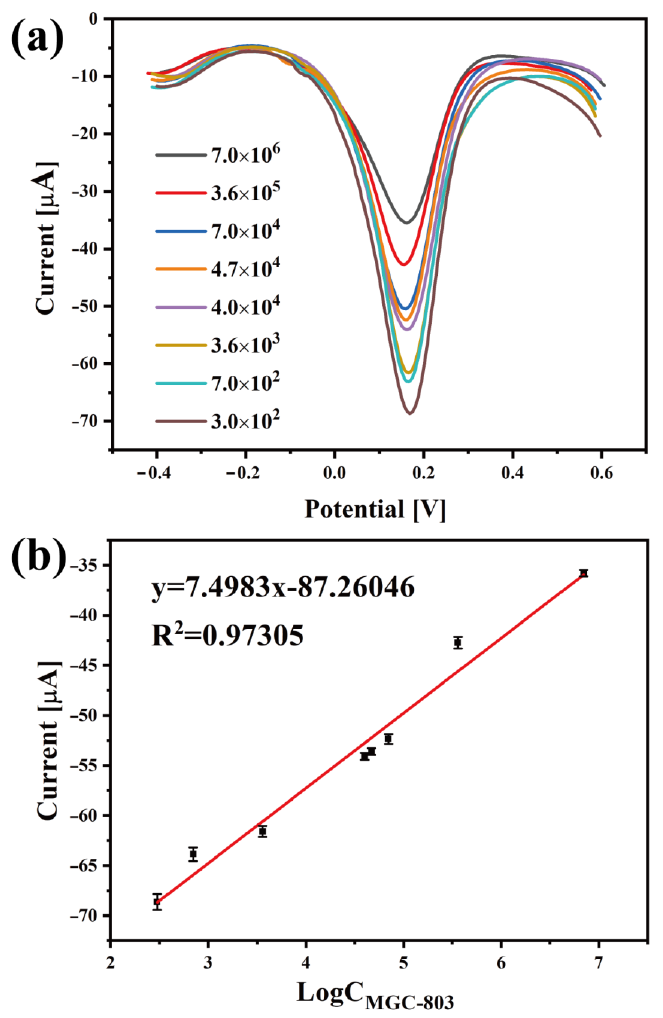
Figure 5. ( a ) The DPV currents of GO-AuNSs@rBSA-FA-labeled electrodes for detecting different concentrations of MGC-803 cells in the range from 3 × 10 2 –7 × 10 6 cell/mL. ( b ) The calibration curve of DpAu/GO-AuNSs@rBSA-FA/BSAT electrodes with respect to MGC-803 cells. Table 2. The performance of this cytosensor compared with others reported.